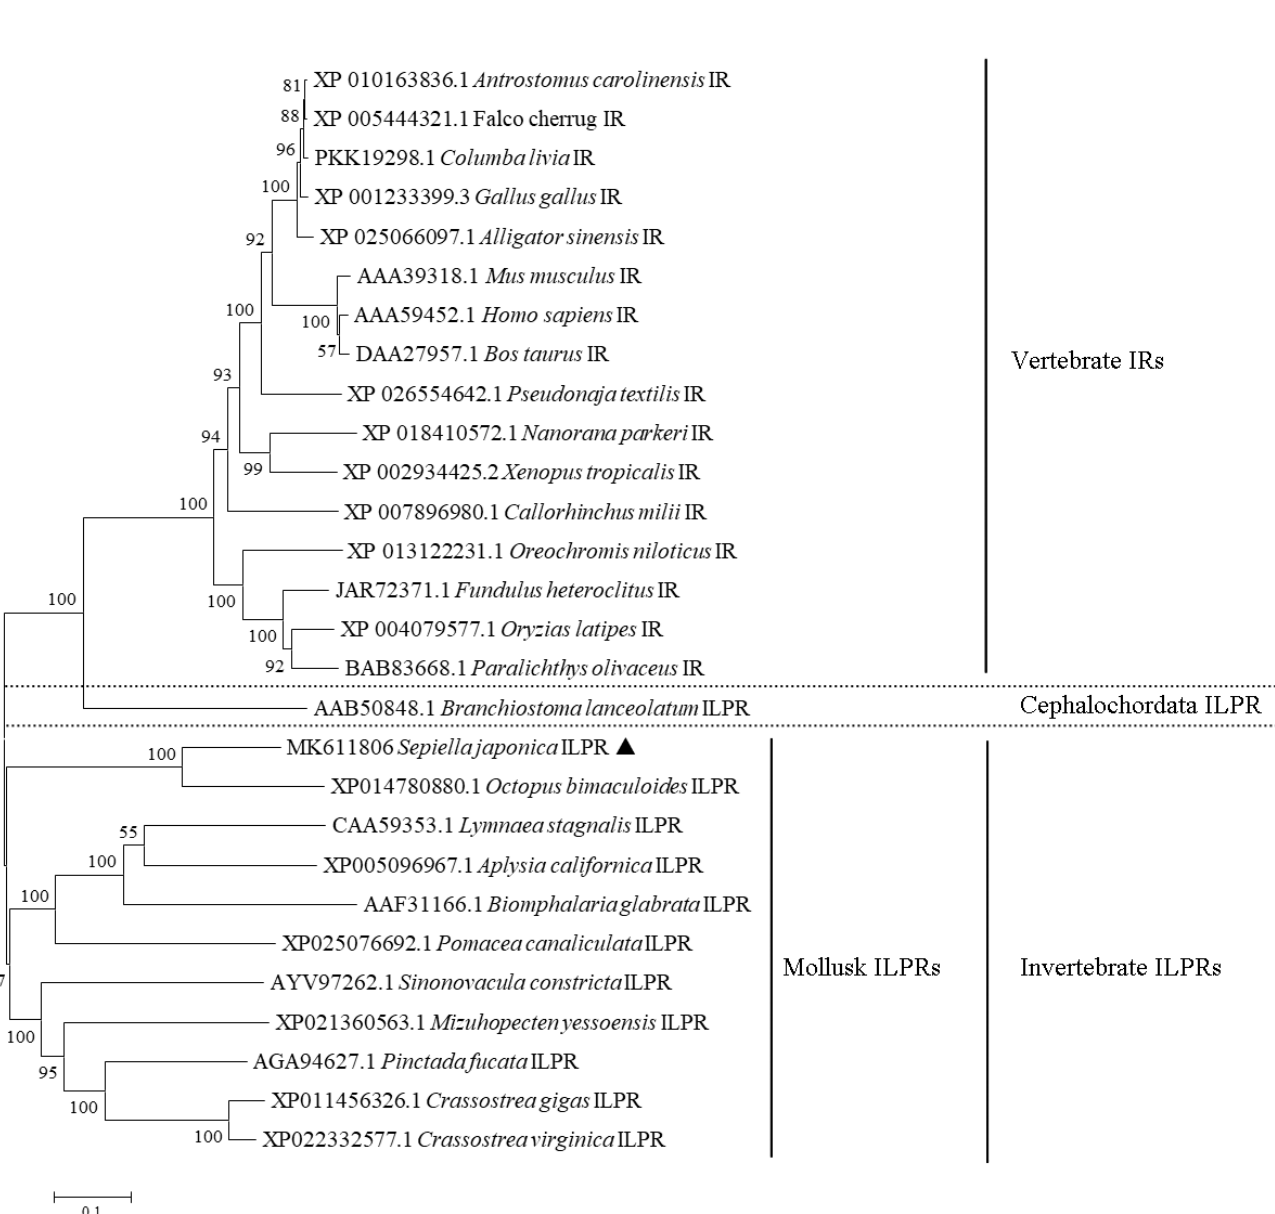
Figure 3. Phylogenetic tree of IR amino acid sequences of vertebrates and invertebrates. The tree was constructed by MEGA7.0 using the neighbor-joining method with 1000 bootstrap replicates. The triangle indicates Sj ILPR.